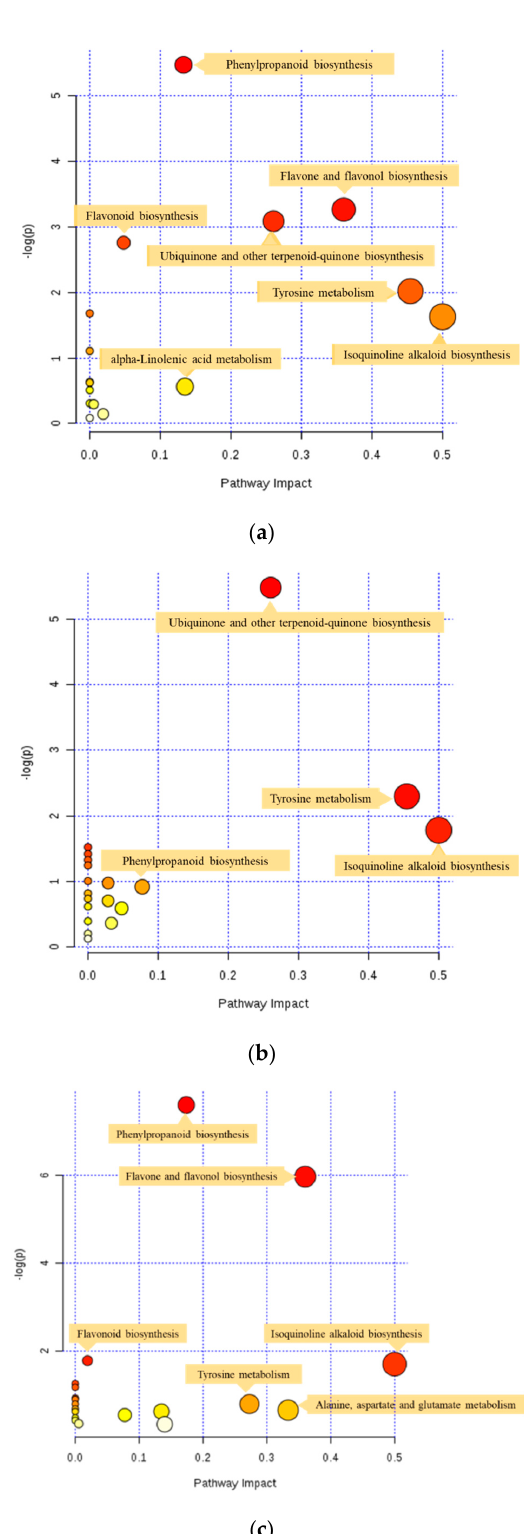
Figure 3. Pathway analyses of differential metabolites between Chinese and Canadian rapeseeds ( a ), Chinese and Mongolian rapeseeds ( b ), and Canadian and Mongolian rapeseeds ( c ). Every circle represents one pathway, and the deeper color represents the more significant changes of the metabolites in the related pathway. Meanwhile, the larger circle means the higher centrality of the metabolite in the related